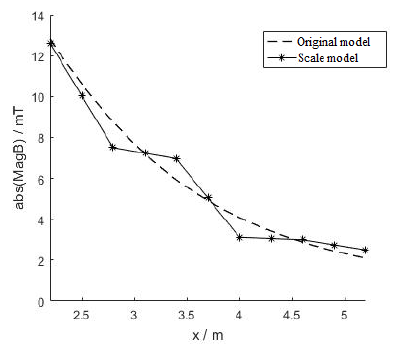
Figure 18. Center radial magnetic field of scaled model and actual reactor.